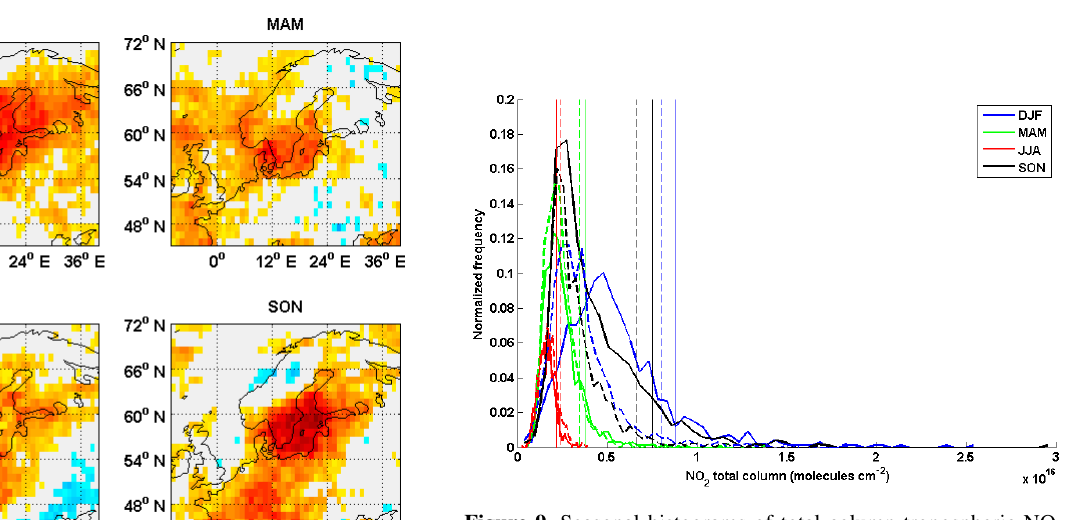
Figure 9. Seasonal histograms of total column tropospheric NO 2 over the centre of the study area (55–60 ◦ N, 11–20 ◦ E) and cor- responding 90th percentile thresholds (shown by vertical lines). The solid lines show histograms based on retrievals under partially cloudy conditions, while the dashed lines show histograms based only on cloud-cleared